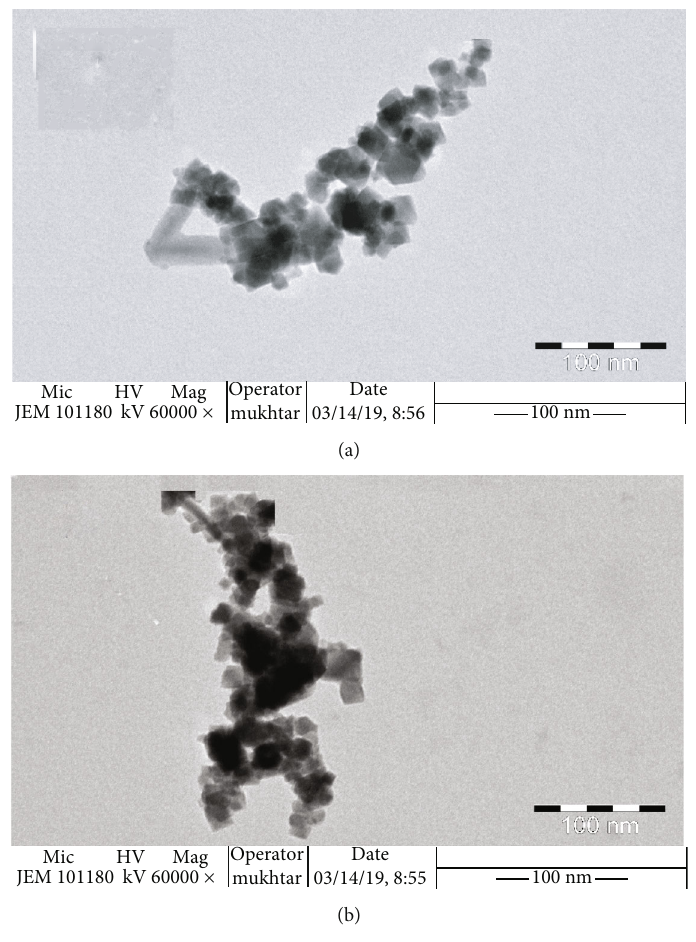
Figure 6: TEM micrographs of (a) NTEPA/Fe